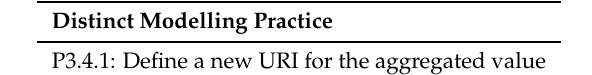
Table 34. Single modelling practice of data portals regarding aggregated values.